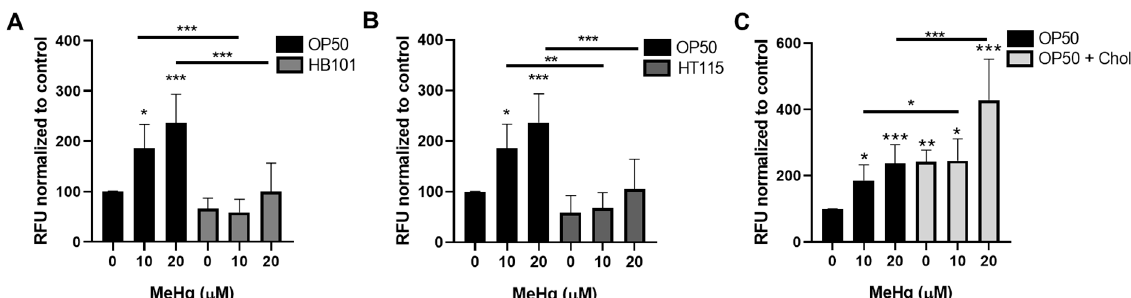
Figure 4. MeHg-induced fat accumulation in worms fed high-fat, but not low-fat, diets. Worms were treated with MeHg for 30 min and placed on NGM plates containing OP50 or ( A ) HB101, ( B ) HT115, or ( C ) OP50 supplemented with cholesterol. Then, 72 h after treatment, worms were fixed, stained with Nile Red, and fluorescence was measured. Data represent mean Nile Red fluorescence normalized to worm number and protein content ± SEM from five independent experiments. * p < 0.05, ** p < 0.01, *** p < 0.001 as compared with untreated, OP50-fed control. Horizontal bars represent comparisons between Hg-treated worms fed different diets.